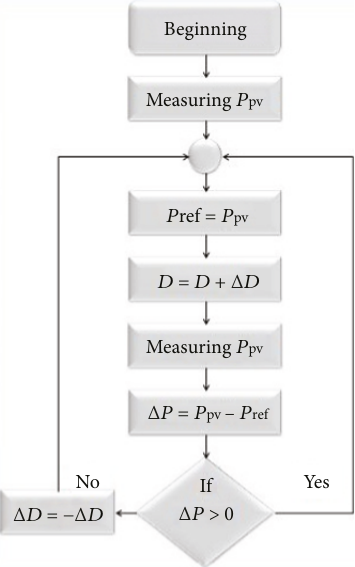
Figure 3: Flowchart of the P&O algorithm.